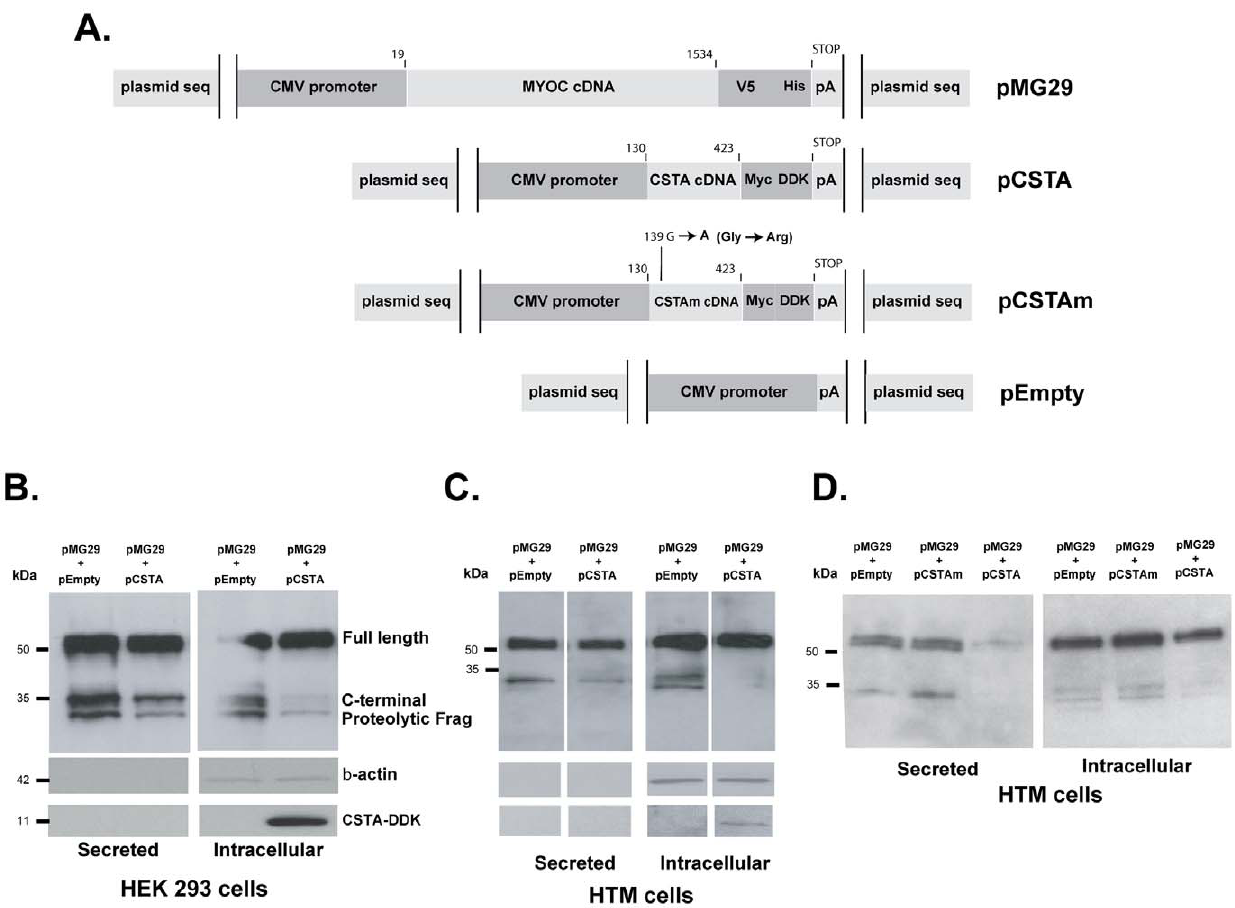
Figure 9. Cystatin A inhibits the processing of MYOC wild-type in cultured cells. Recombinant expression plasmids containing tag-fused full coding wild-type MYOC (pMG29), CSTA, and controls plasmids, inactive mutated CSTA (CSTAm) and pEmpty, were generated as indicated in Methods. pMG29 was co-transfected with either pCSTA, pCSTAm or pEmpty (1:2) and harvested at 48 h post-transfection. Equivalent volumes of cell extracts and of their supernatants were loaded onto 4–15% SDS-PAGE gels, transferred to PVDF membranes and analyzed by immunoblotting. Different MYOC protein forms (full length and processed) were detected with an anti-V5 mouse monoclonal followed by an anti-mouse horseradish peroxidase antibodies. Blots were re-probed with b -actin and DDK antibodies for loading and identification controls. Percent of the MYOC processed band was calculated by densitometry. A) schematic representation of the expression cassettes of the recombinant plasmids. B, C and D: Representative western blots with extracts from transfected cells. B) extracts from HEK293 co-transfected by calcium phosphate. C and D) extracts from primary HTM-137 cells co-transfected by nucleofector electroporation.